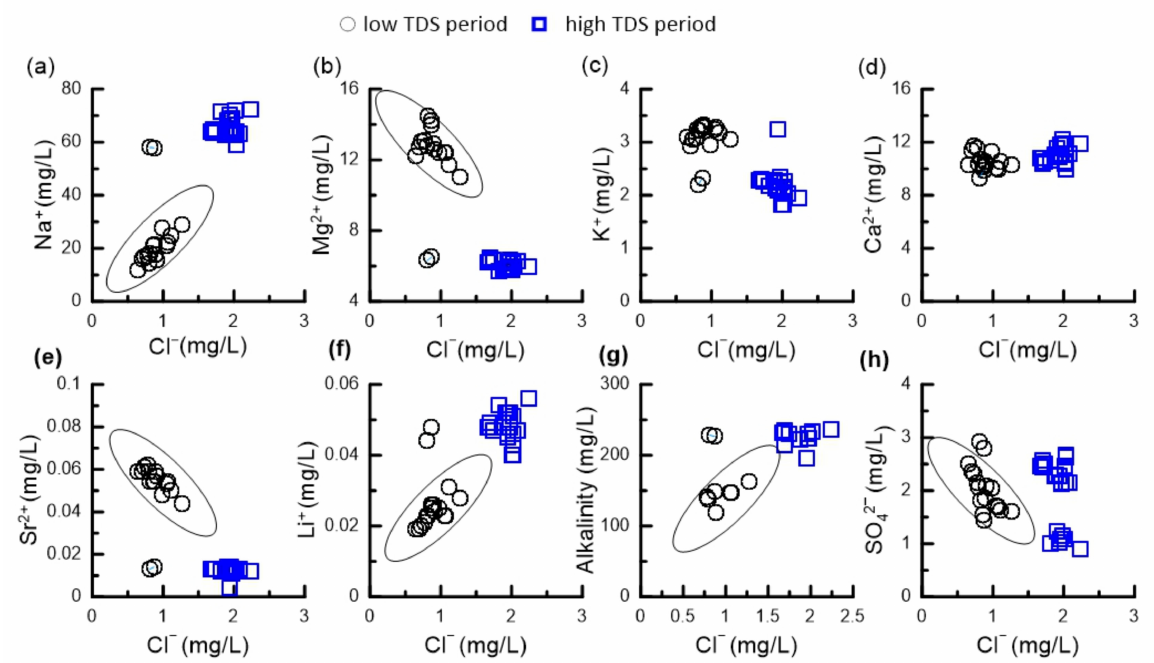
Figure 6. Relationship between Cl − and ( a ) and ( e ) total dissolved solid (TDS), ( b ) and ( f ) alkalinity, ( c ) and ( g ) SO 42 − , and ( d ) and ( h ) F − in the BDS and BSS bottled waters, respectively.